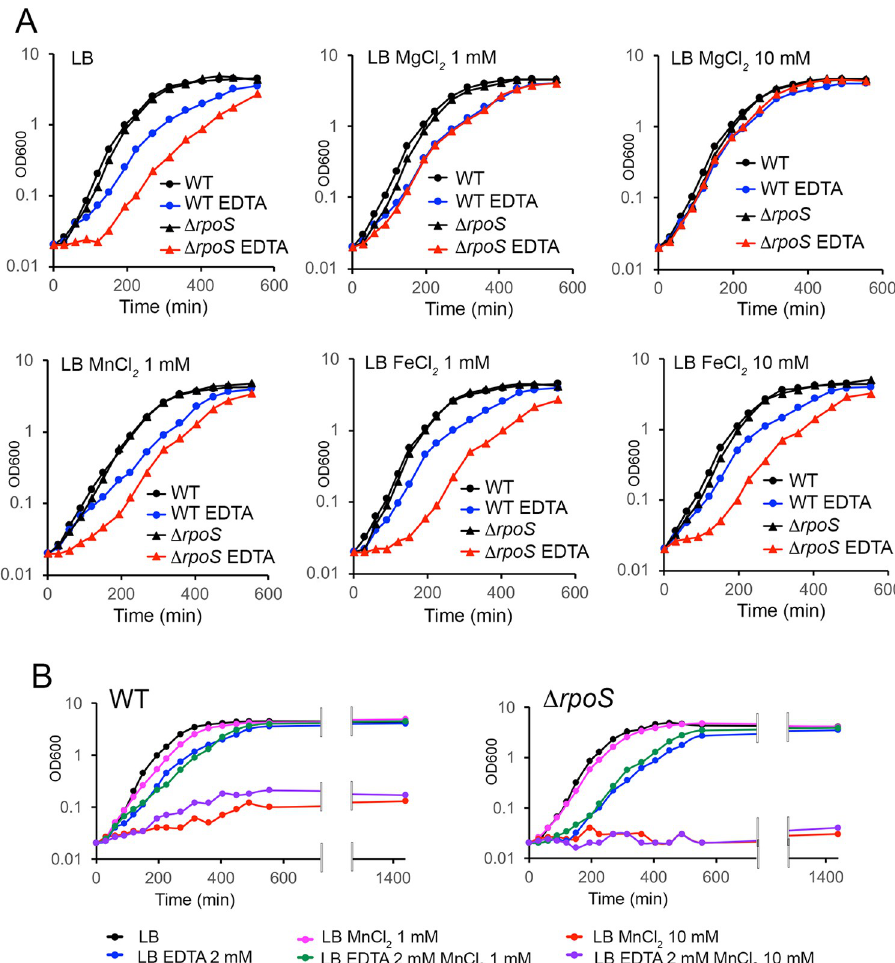
Fig 8. Magnesium abolishes the effects of EDTA in add-back experiments. Kinetics of growth of the wild-type strain (WT VF6910) and the Δ rpoS mutant (VF8158) was followed in LB supplemented or not with EDTA 2 mM and the indicated metal ions. The growth phase was determined by the measurement of culture turbidity at OD 600 nm. The experiments were repeated twice with similar results (see S5 Fig for a repeat experiment).